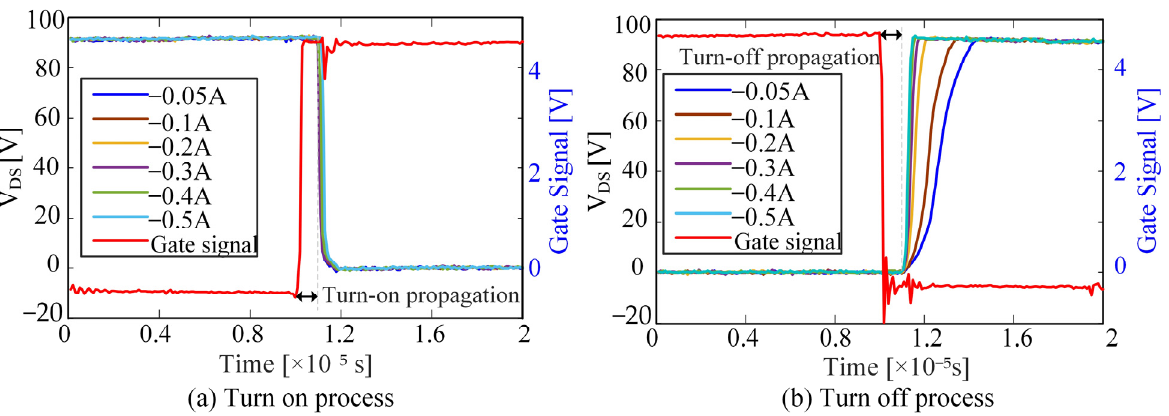
Figure 9. Influence of negative current with different amplitudes on the drain source voltage.